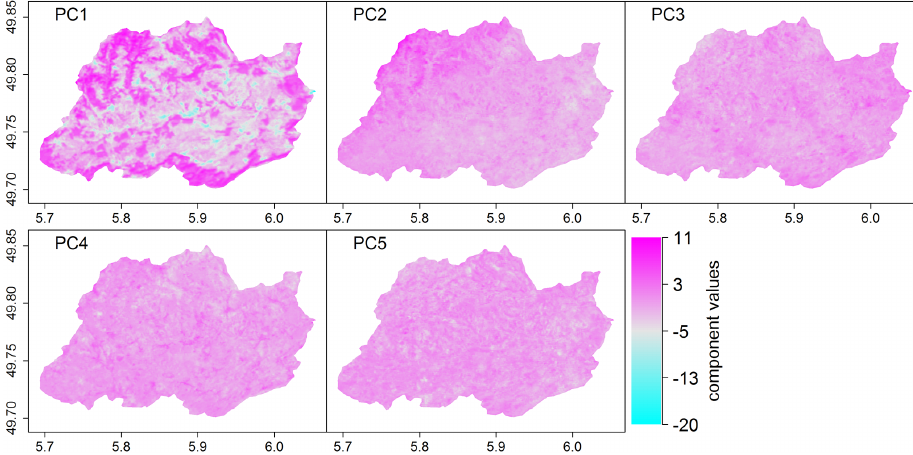
Figure 8. The first five components of the PCA for the LST time series